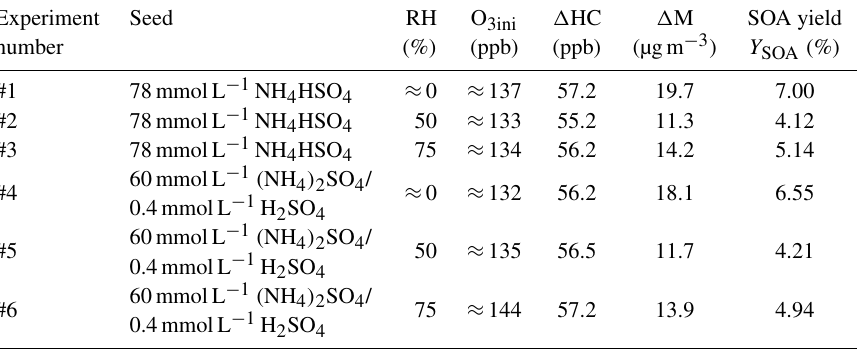
Table 2. Experiments in the aerosol chamber LEAK for the OH radical oxidation of 1,3,5-TMB. All experiments were conducted at 293K and with 91.9ppb 1,3,5-TMB.